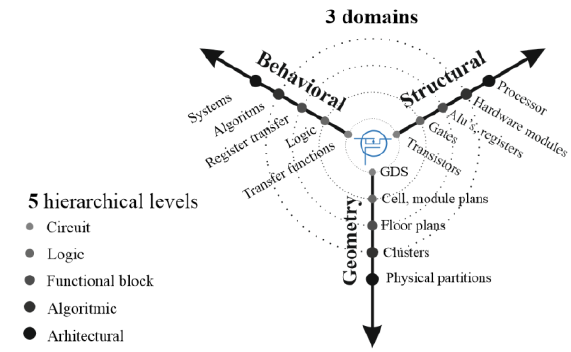
Fig. 5. Gajski-Kuhn